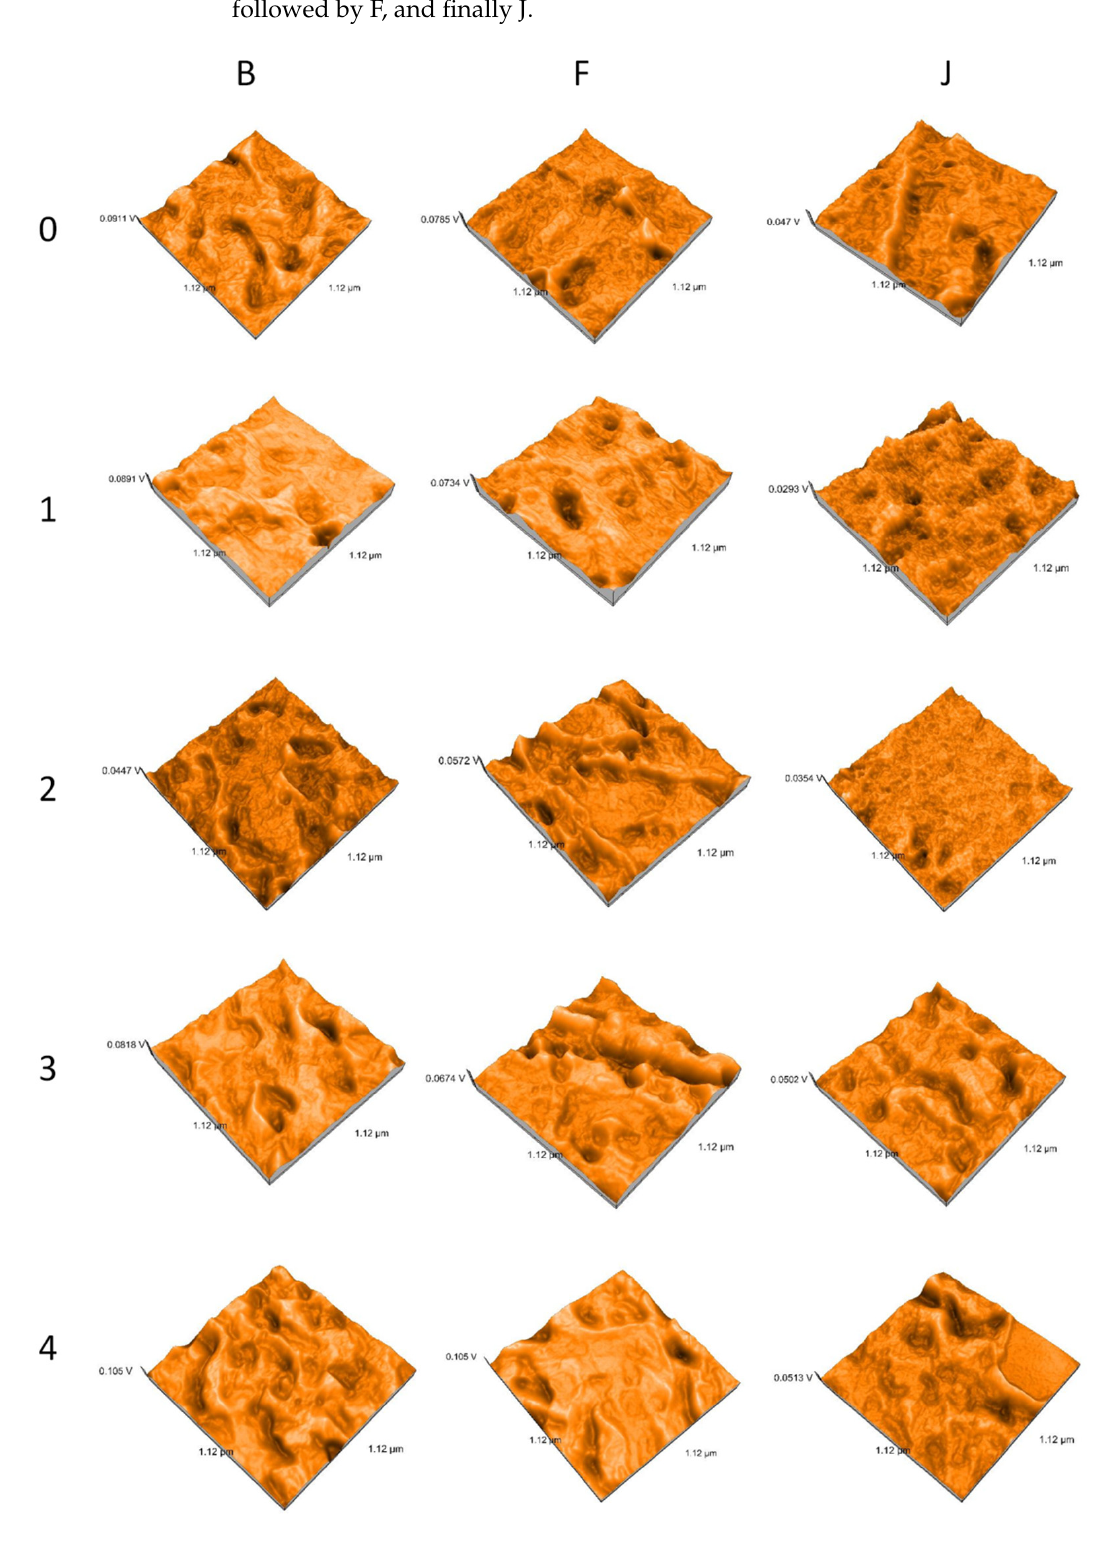
Figure 3. 3D reconstructions of AFM images.